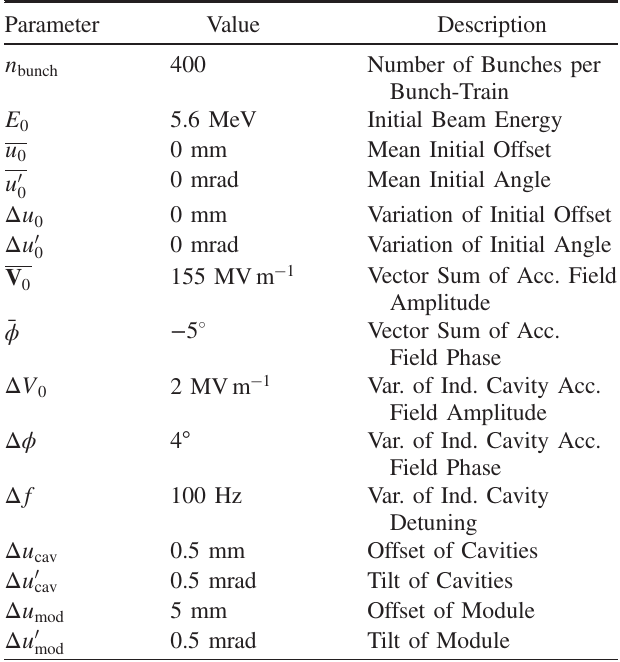
Var. of Ind. Cavity